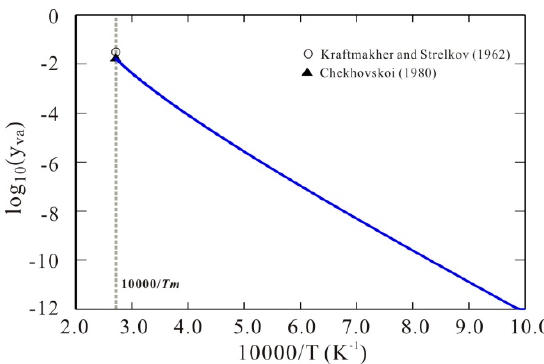
Figure 3. Arrhenius plots of thermal vacancy concentration of bcc W. Symbols: Experimental data at melting point from [9,10]. Solid line: Calculated thermal vacancy concentration of bcc W according to the presently established Gibbs energy for bcc W. A clear curvature is obtained for the Arrhenius plot of thermal vacancy concentration of bcc W.